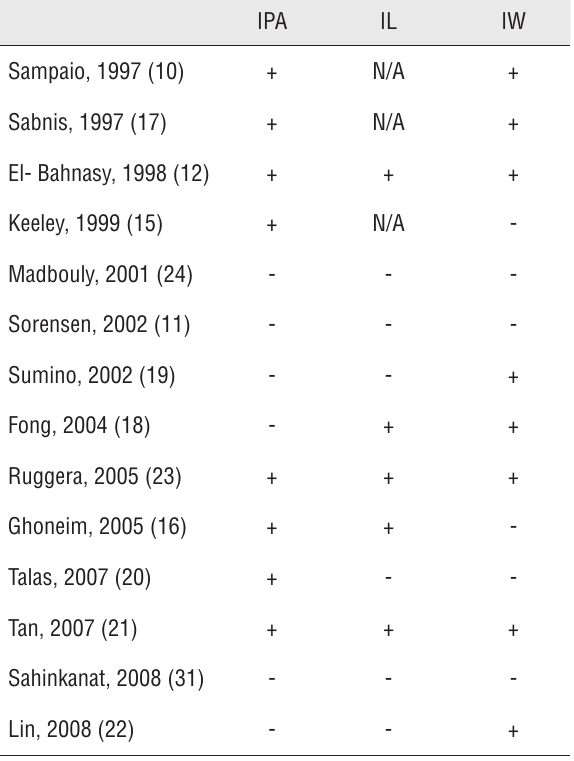
Table 5 - Results of some studies investigating the effect of IPA, IL and IW on success after